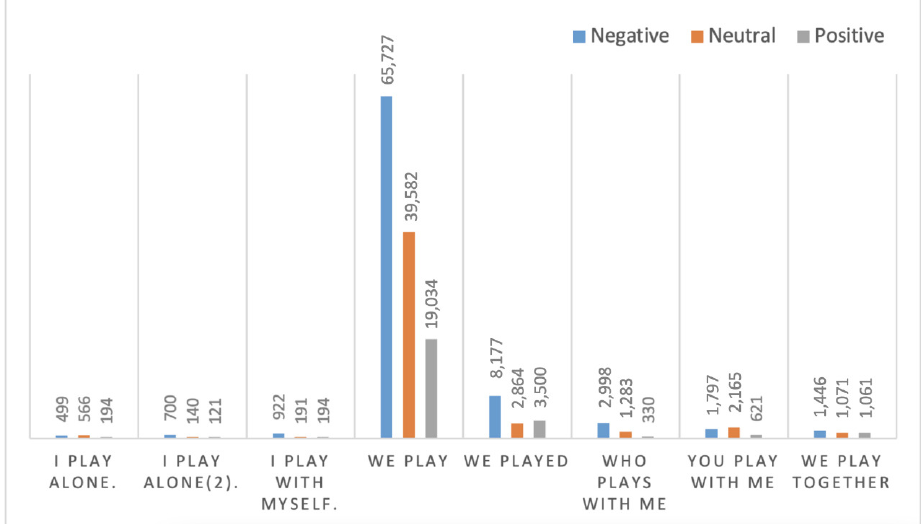
Figure 2. The result of sentiment analysis on collected key